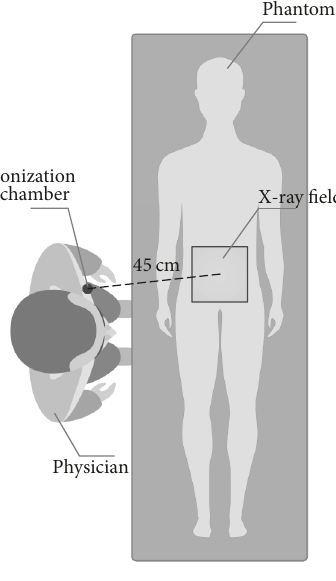
Figure 2: The geometry of measurement on the angiography system for